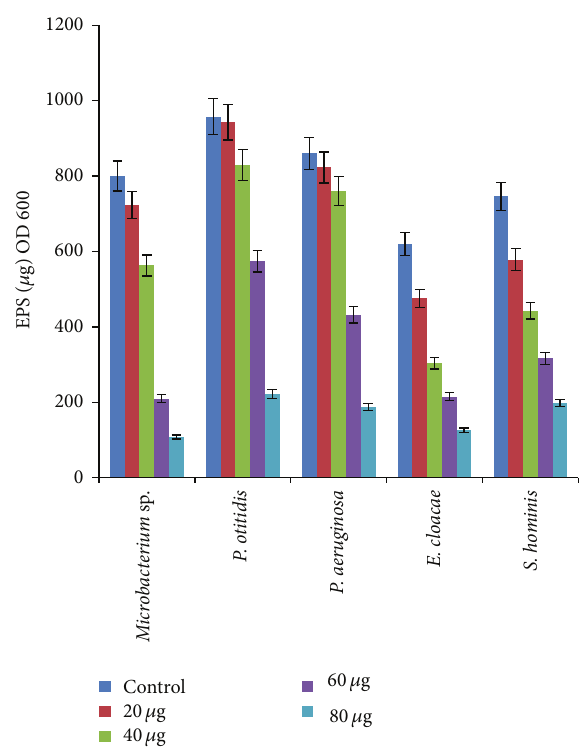
Figure 5: The effect of biosynthesized AgNPs on EPS production by marine biofilm forming bacteria.